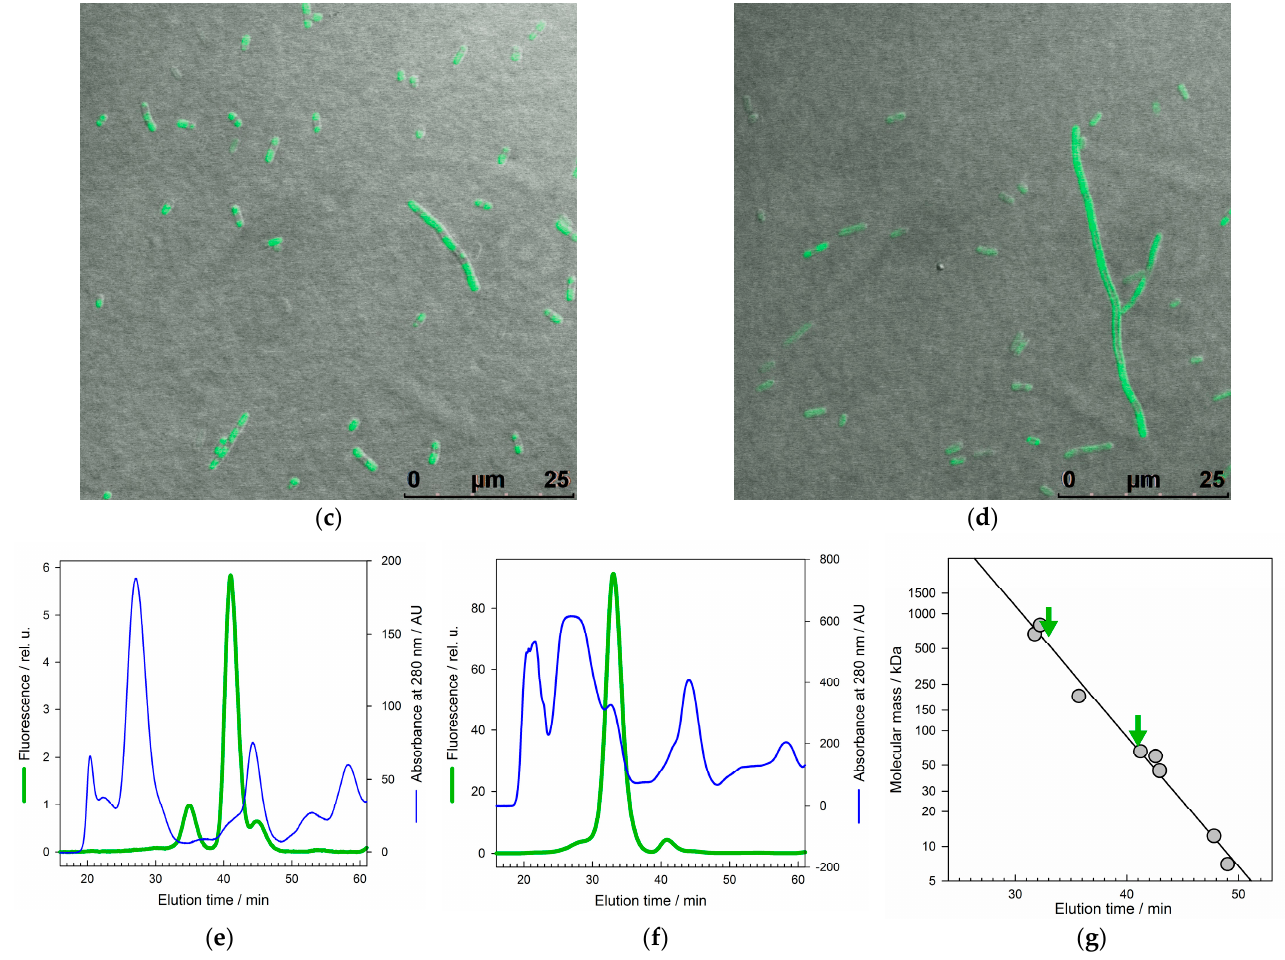
Figure 1. Incorporation of the photoprotein EGFP into the GroEL 14 structure: schematic represen- tation of the genetic constructs encoding the GroEL subunit fused with photoprotein ( a ) and the WT groE operon (GroEL + GroES genes) of E. coli cells ( b ); fluorescent microscopy images of E. coli cells after the expression of pAC28 groEL-EGFP alone ( c ) and its coexpression with pET11c groES/EL ( d ); size-exclusion chromatography profiles of the corresponding cell lysates are shown in ( e , f ), and the column calibration is in ( g ); the green arrows indicate the elution times of mono- meric GroEL 1 -EGFP and oligomeric GroEL 14 -EGFP. Abbreviations in the schemes ( a , b ) mean the following: pAC28 groEL-photoprotein and pET11c groES/EL are names of the constructed plas- mids; Kan is the gene encoding resistance to kanamycin; p15A ori is the origin of replication p15A; lacI is the lac repressor; bla is the beta-lactamase gene; ori is the origin of replication ColE1; rop is the gene of Rop protein; NcoI , EcoRI , SalI , and NdeI are restriction sites.